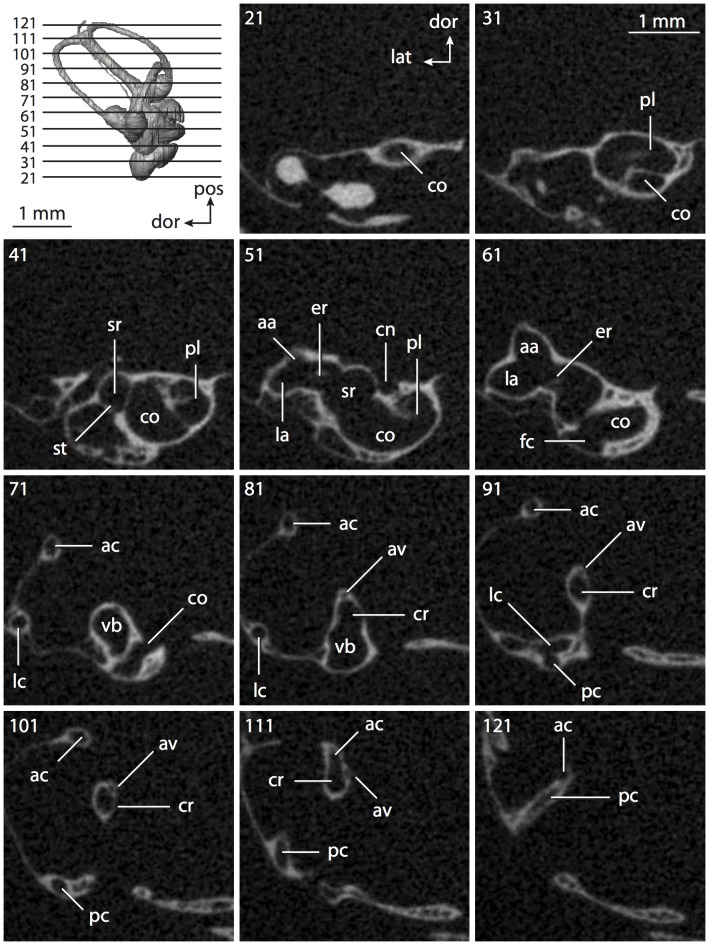
CT slices through ear region ofSorex monticolus.Abbreviations listed at the end of the Materials and Methods section.